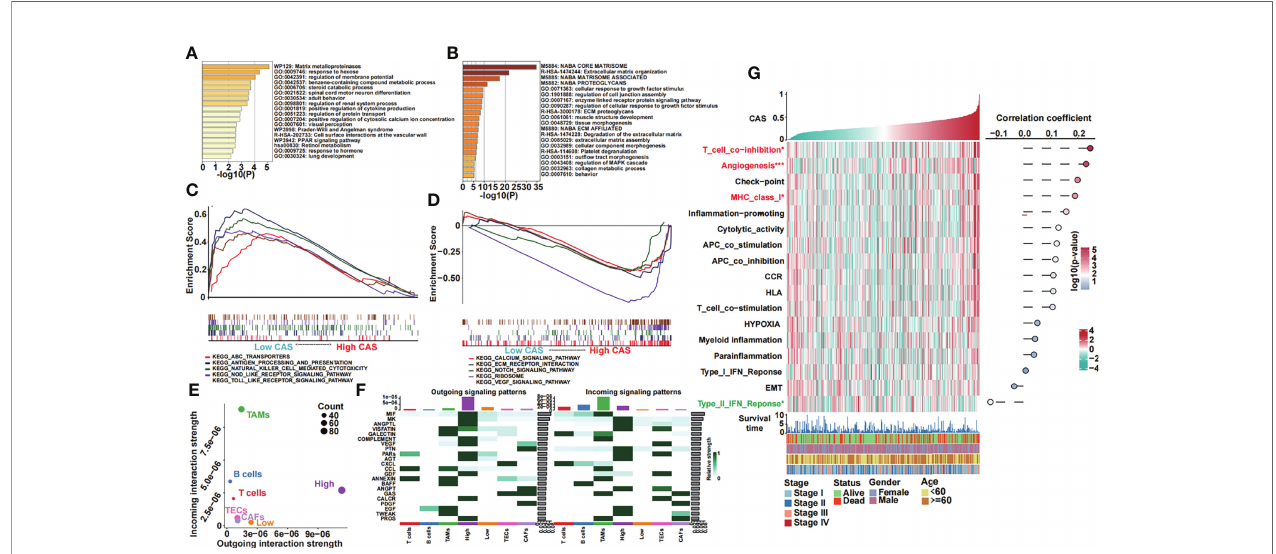
FIGURE 5 | Functional analyses of our constructed ANN model. (A) GO analysis of differentially expressed genes in high-CAS samples was performed in Metascape. (B) GO analysis of differentially expressed genes in low-CAS samples was performed in Metascape. (C) Five KEGG pathways were enriched in the low- CAS samples by performing GSEA. (D) Five KEGG pathways were enriched in high-CAS samples by performing GSEA. (E) Summary of the crosstalk of the subclusters. (F) Outgoing and incoming signaling of high- and low-CAS samples as well as other cell subclusters. (G) A heatmap illustrating the expression and the correlation between CAS and the pathways of